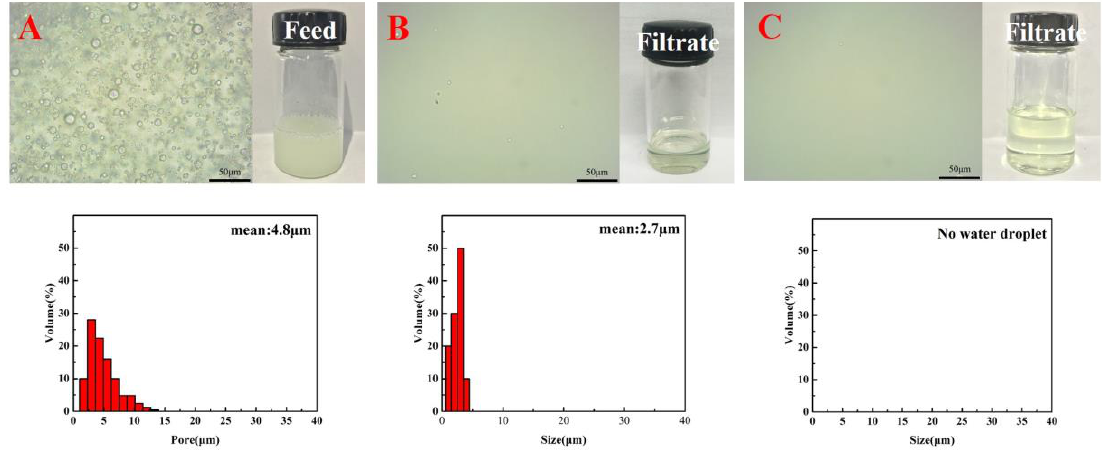
Figure 8. Optical microscope images, photographs and size distribution of surfactant-stabilized water-in-oil emulsion: ( A ) feed; ( B ) M3 filtrate; and ( C ) M3-S2 filtrate.